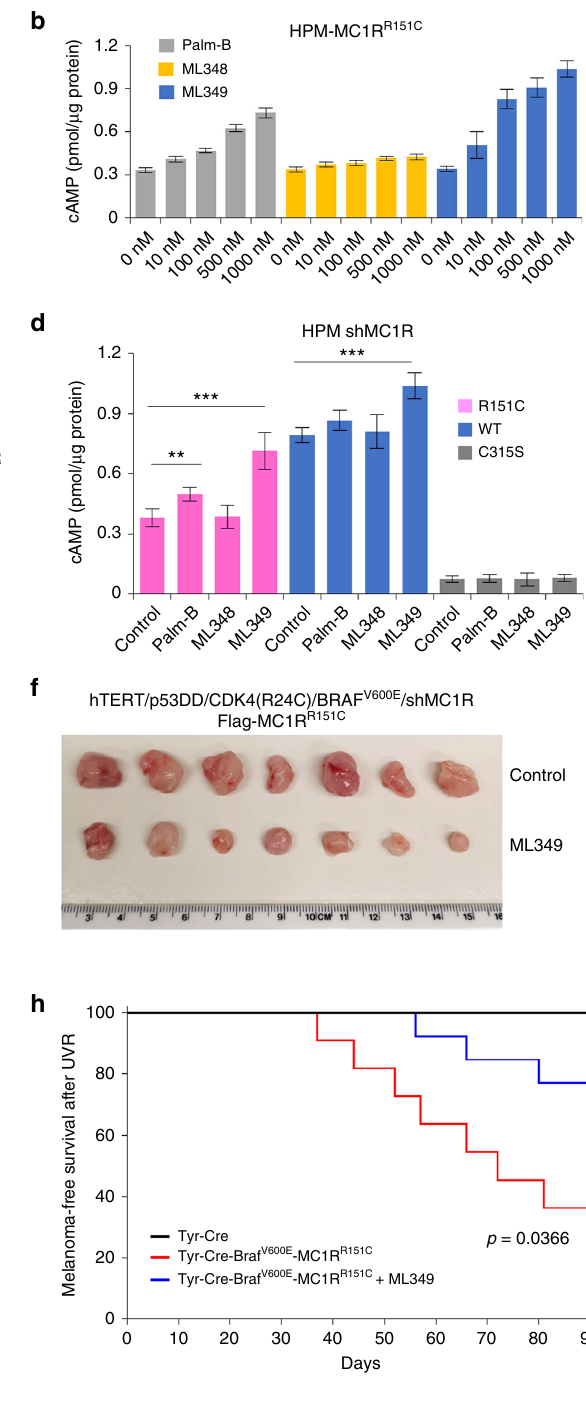
process controlled both by palmitoyl acyltransferases, which mediate palmitoylation, and PPTs, which remove this modi fi ca- tion (Fig. 4a and Supplementary Fig. 3a). Increasing MC1R pal- mitoylation in vivo would potentially diminish melanoma incidence, especially for redheads in whom MC1R signaling is compromised. To increase MC1R palmitoylation, we compared the effects of three commercially available depalmitoylation inhibitors, including Palmostatin B (Palm-B) 23 , ML348, and ML349 37 . Palm-B is a newly described inhibitor of the deacylating enzymes APT1, APT2, and ABHD17 and therefore speci fi cally inhibits depalmitoylation 38 , whereas ML348 is a newly described